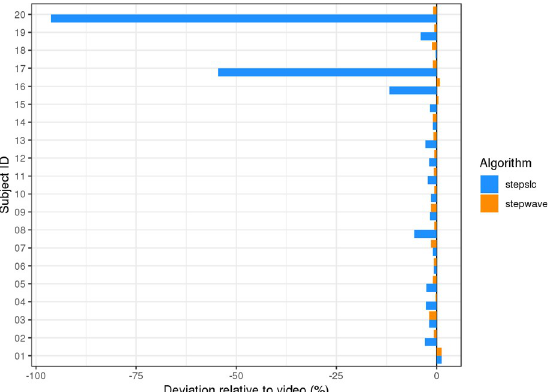
Fig 2. Comparison of step counts. Comparison of the deviation from the video recorded steps (estimated steps divided by video steps minus 1) in percent for the two step detection algorithms. The vertical line at 0 depict identical step counts for video and